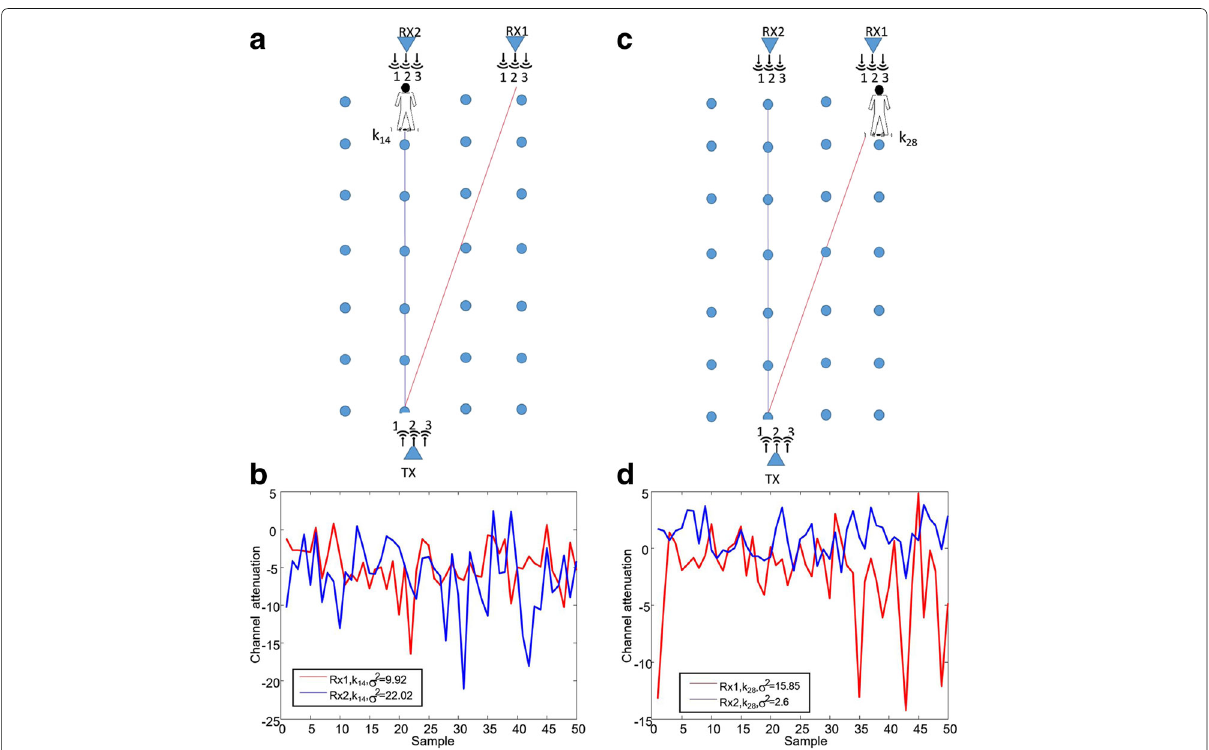
Fig. 3 Target-induced channel attenuation for the link (cid:2) 5 , identified by the antenna pair ( u = 2, v = 2 ) , and the by the sub-carrier f 15 . In a , the target is located at position K 14 , and in b , the corresponding CSI values are measured by both RX1 and RX2 receivers. In c , the target is located at position K 28 , while in d , the corresponding channel attenuation is measured by both RX1 and RX2